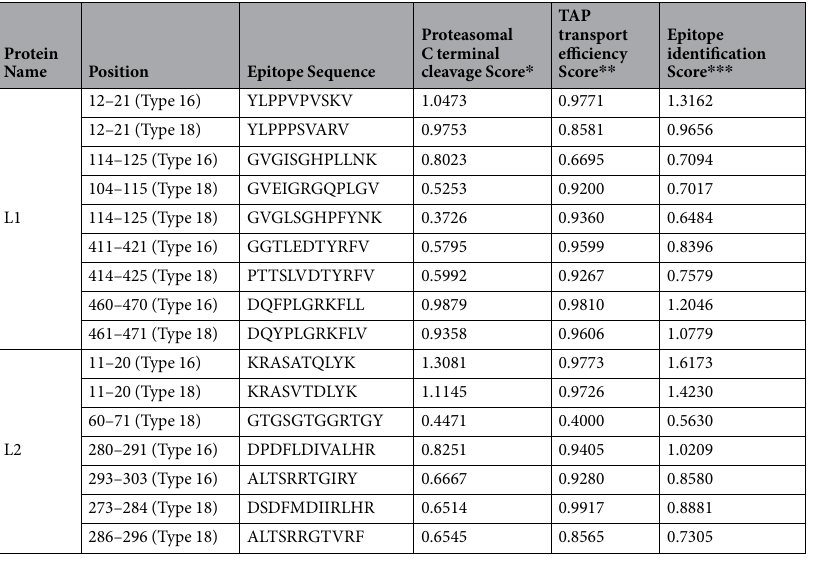
Table 8. Proteasomal cleavage and TAP transport efficiency scores of MHC-I predicted epitopes. * Higher rates show better quality of proteasomal cleavage, ** Higher rates show better quality of tap transport efficiency, *** Higher rates show better quality of epitope